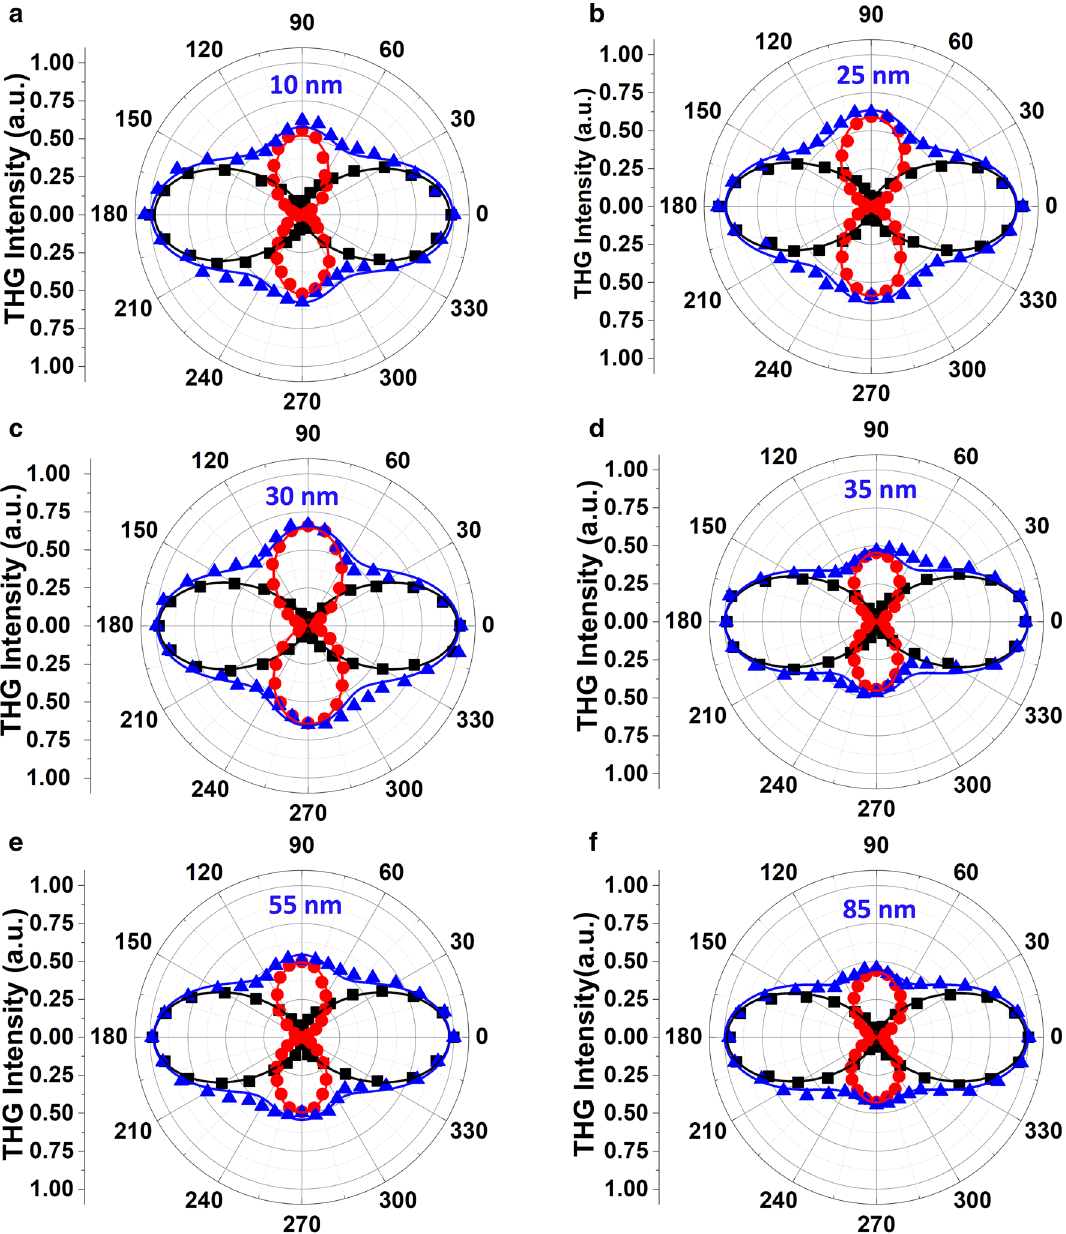
Figure 3. The angle-resolved THG intensity with respect to the incident linear polarization angle for the SiP flakes with thicknesses of (a) 10nm , (b) 25nm , (c) 30nm , (d) 35nm , (e) 55nm and (f) 85nm . The black squares, red circles and blue triangles represent the measured x -component, y -component and total THG intensity, respectively. Solid black, red and blue curves refer to the data fittings by Eqs. (9) and The black squares and red circles are the measured THG emission components along the armchair direction ( I 3 ω x ) and the zigzag direction ( I 3 ω y ) respectively, while the blue triangles represent the total THG emission ( I 3 ω ) with respect to the incident polarization angle. For all the flakes, the maximum THG signal is emitted as the input laser polarization is aligned along the armchair direction of the 2D SiP crystal, while the second maximum THG emission is occurred for the laser polarization along the zigzag direction of the crystal. The varying THG emission intensities for different incident polarization angles validate the strong anisotropic nonlinear optical response of 2D SiP. It is clearly shown that the input laser polarization angle where the maximum THG signal is obtained is in a perfect match with the angle of the armchair direction determined by the angle-resolved Raman measurements, manifesting that the nonlinear optical anisotropy of 2D SiP observed in THG measurements and the structural anisotropy determined by Raman measurements are in phase along the armchair and zigzag directions. Furthermore, the measured data is fitted by Eqs. (9) and (10) to estimate the components of the third-order nonlinear susceptibility tensor. The calculation results are depicted as the solid black, red and blue